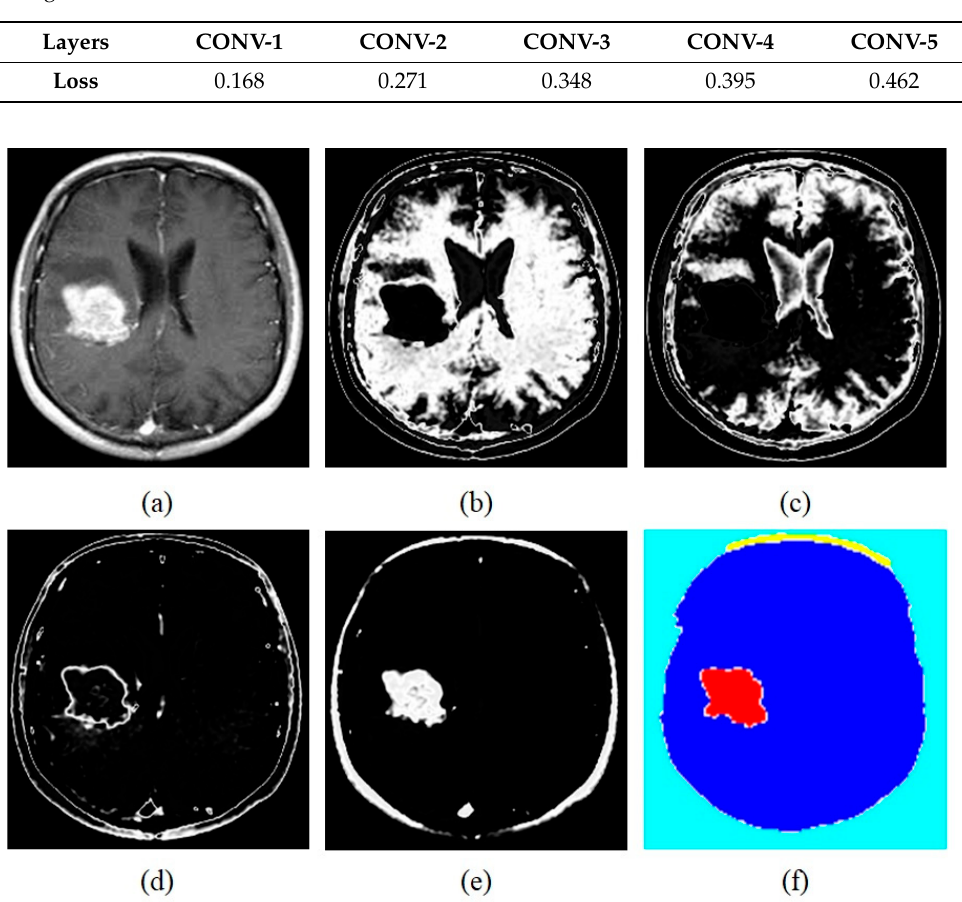
Table 4. MSE Loss at each convolutional Layer of Proposed Transfer Learning based DCNN Model on Figshare dataset. Figure 5. Tumors Detection Results using Proposed Framework ( a ) Original brain MR Image with tumor ( b ) White matter ( c ) Segmented Image ( d ) Gray matter ( e ) Skull-stripped image ( f ) Extracted Tumor.